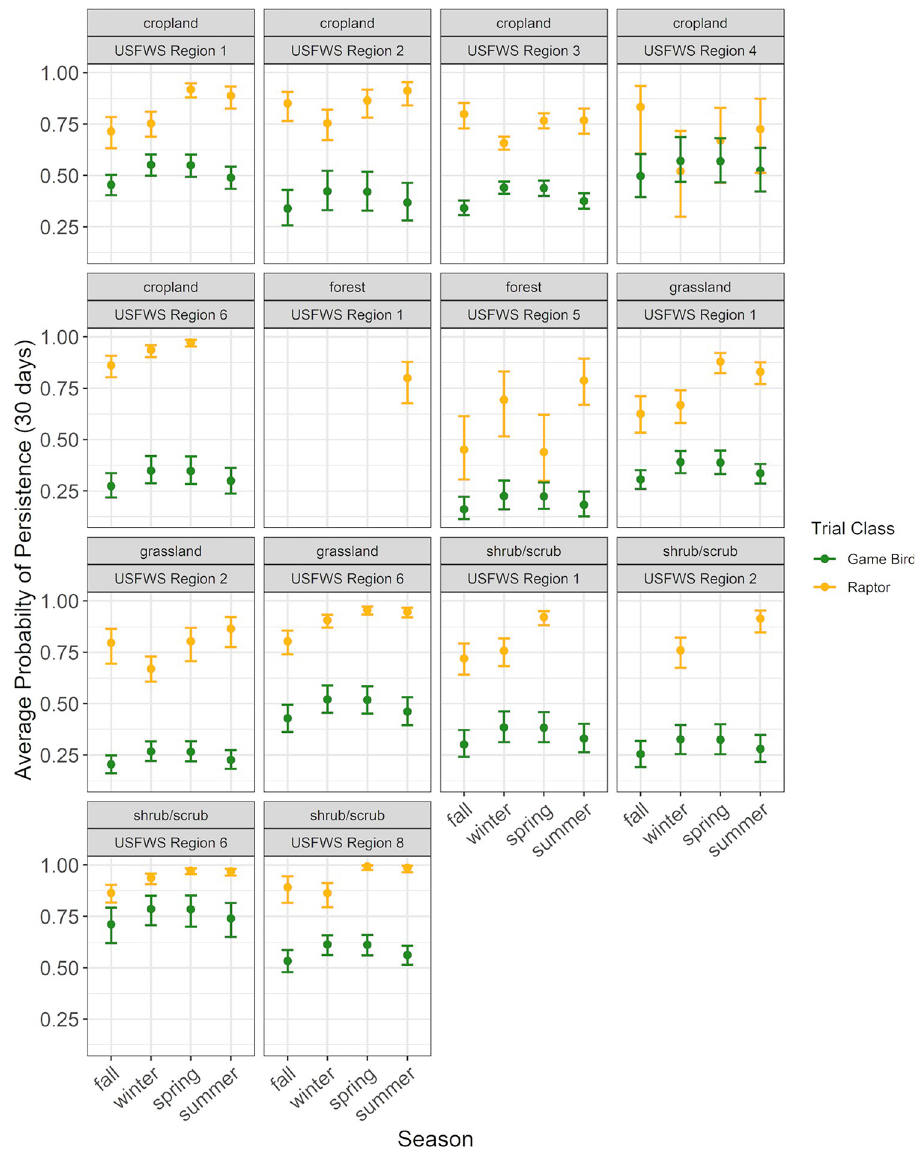
Fig 10. Modeled average probability of persistence through a 30-day search interval for all raptor and game bird carcass meta-data, limited to sampled strata. Average probability of persistence through 60- and 90-day search intervals for both bird types followed the patterns shown here, but were shifted lower on the vertical axis because average probabilities of persistence decreased as search intervals increased.